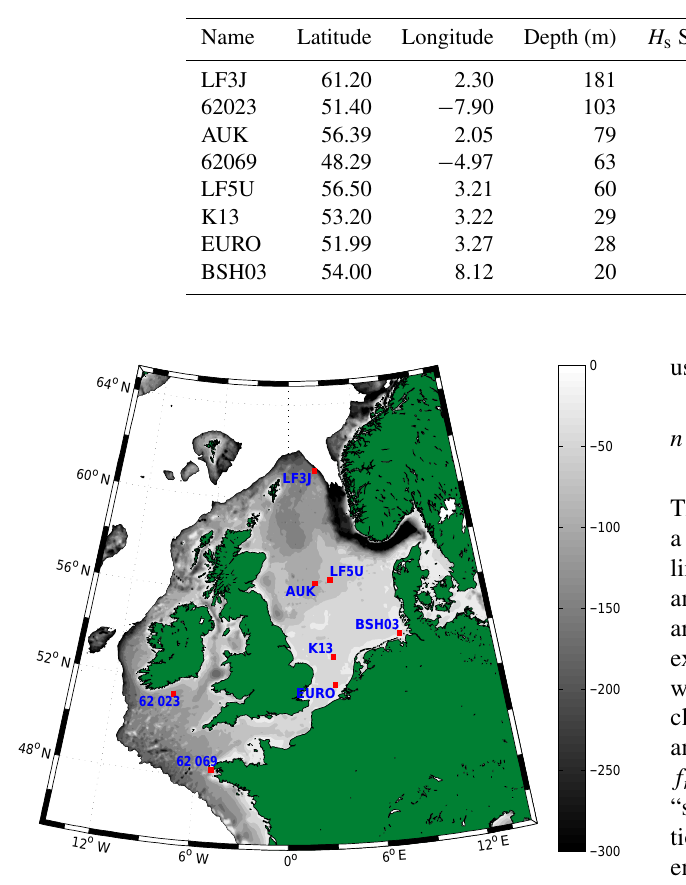
Figure 1. Map of station positions. Depths less than 300m are in- dicated in